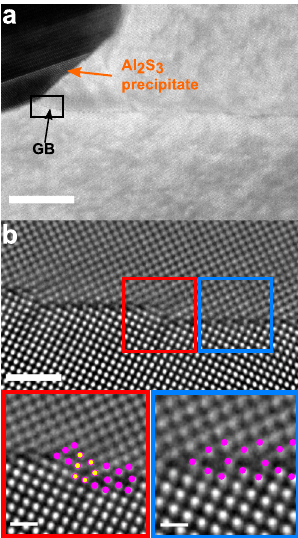
Fig. 3 Grain boundary nano-facetting in close vicinity to a GB precipitate. a HAADF-STEM image taken near the Al 2 S 3 precipitate. The black rectangle indicates region where the boundary is bend. b Atomic resolution image of the region within the black rectangle showing nm- sized facets. The blue and red boxes indicate the symmetric facet and the step, respectively, as well as magni fi ed views of the corresponding structural units. The scale bar is 20 nm in ( a ) and 1 nm in ( b ) and 500 pm in the